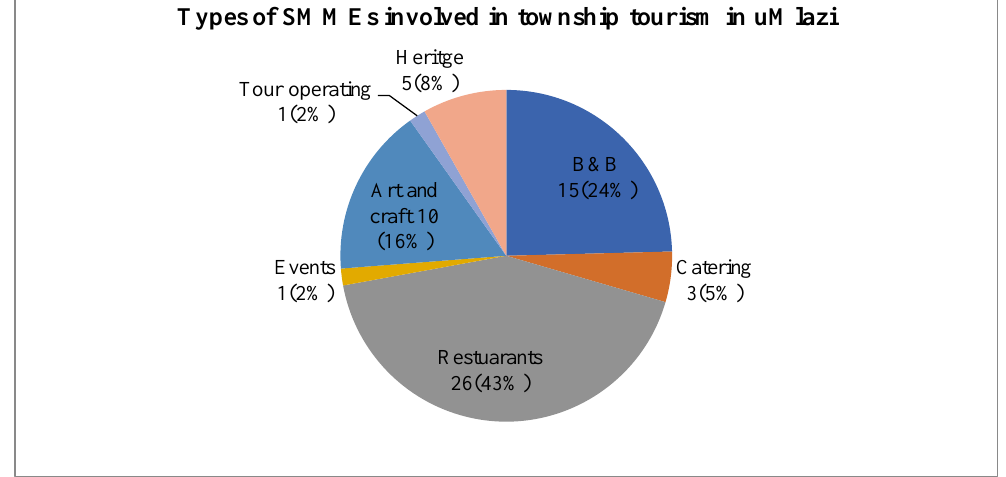
Figure 3: Types of Smmes Involved in Township Tourism Smmes in Umlazi